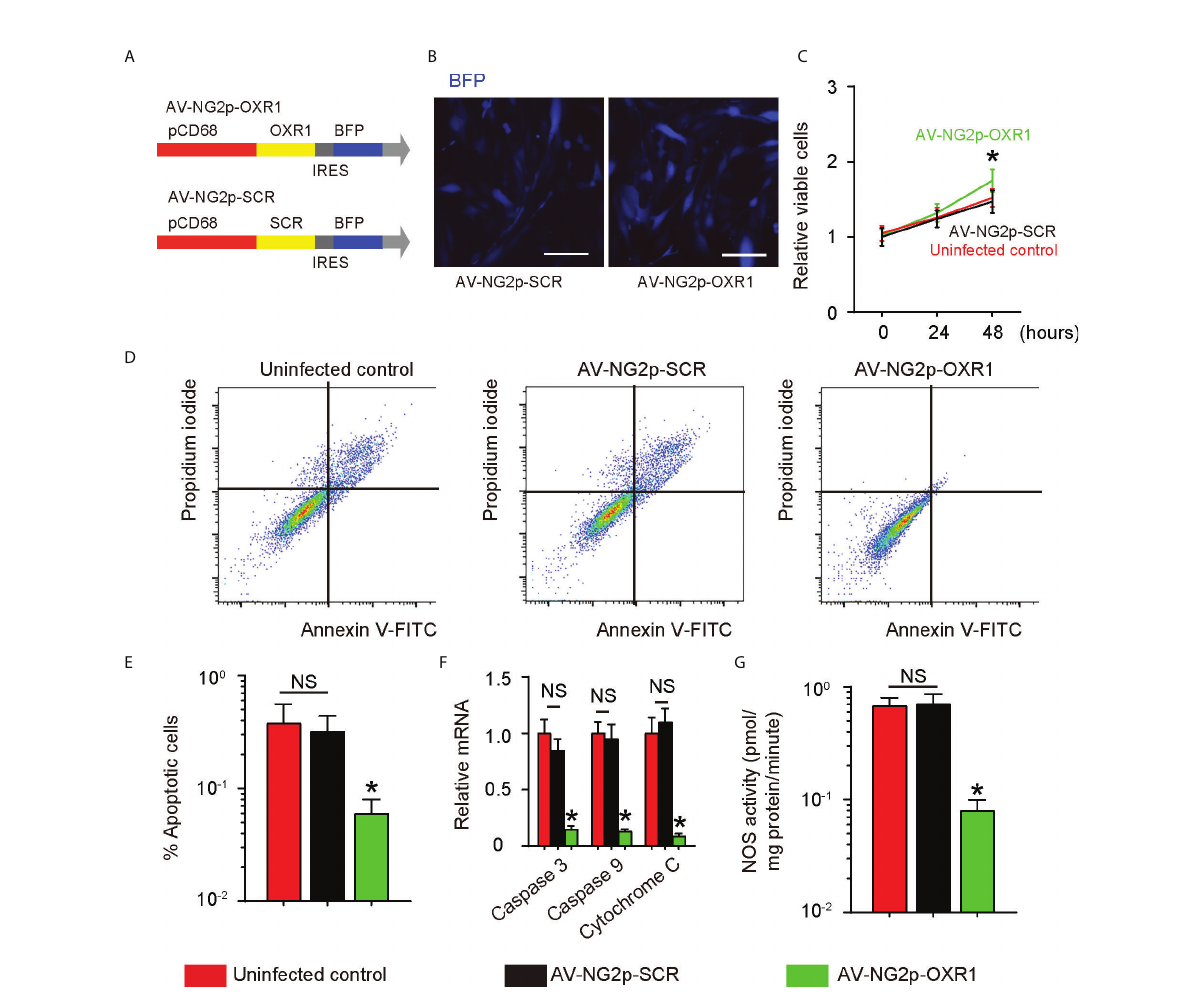
mouse model for type 2 diabetes, in which mice develop high fasting blood glucose as early as 8 weeks old in both genders (Figure 5A). DB/DB mice received injection of control saline or control AV-NG2p-SCR or AV-NG2p-OXR1 at the wound site at 8 weeks old when the wound was generated. Another group of wild-type mice was used as an additional control. Gene therapy with AV-NG2p-OXR1 did not alter the levels of fasting blood glucose in DB/DB mice (Figure 5A) and did not alter beta cell mass at analysis (12 weeks old, or 4 weeks after wound generation with/without saline/virus injections) (Figures 5B, C). Thus, gene therapy with AV-NG2p-OXR1 does not alter diabetic status in DB/DB